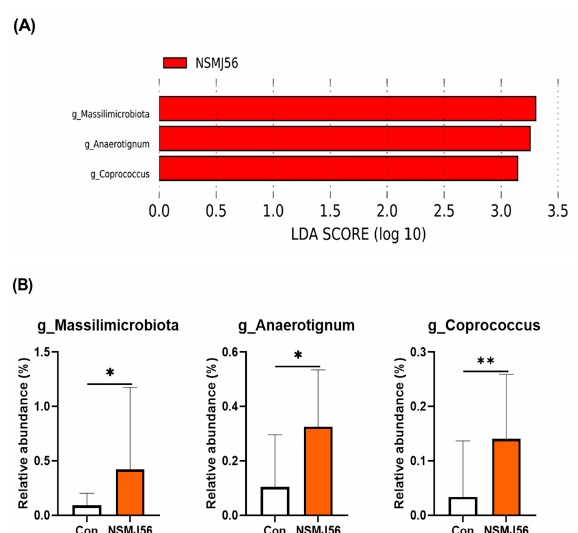
Figure 8. Linear discriminant analysis effect size analysis on the broiler cecal microbiome. Differen- tially abundant microbial distribution is shown for the control group and NSMJ56 group. A bar plot showing LDA scores of the genera that were differentially abundant in ceca microbiome of the NSMJ56 group ( A ). Microbial relative abundance of three differentially abundant genera in the NSMJ56 group were compared with the control group ( B ). Data were obtained from the control group ( n = 10) and NSMJ56 group ( n = 6) and are presented as means ± SD. Significant differences between the control and NSMJ56 groups were analyzed by a Mann–Whitney test. * p < 0.05 and ** p < 0.01.